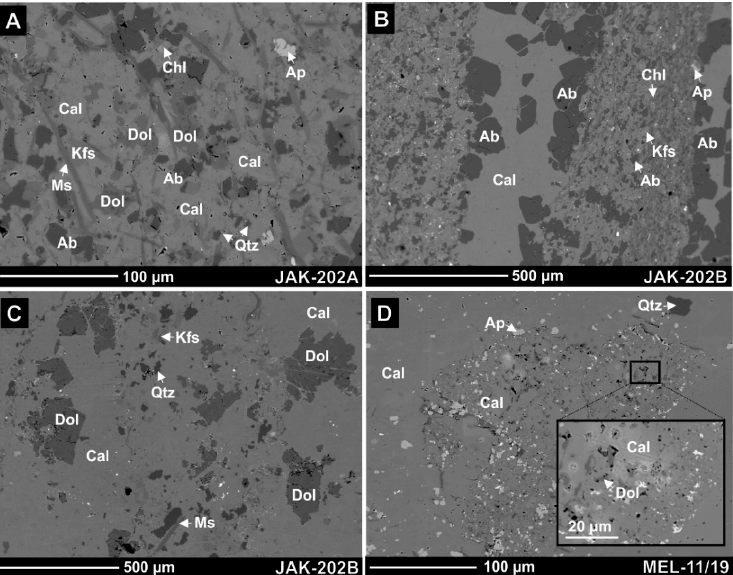
Figure 24. BSE images of carbonate-rich layers in Meliata Unit flysh ( A – C ) and a marble olistolith from the inferred B ô rka Unit ( D ); ( A – C ) Cal–Dol–Ab–Chl–Kfs–Qtz assemblage of the peak (D1) metamorphic stage from the carbonatic layer of calciclastic flysch at Jaklovce; ( D ) Cal–Dol–Cel-Ms assemblage of the peak (D1) metamorphic stage from a marble mylonite block in flysch at Meliata village. Younger coarse-grained Cal occurs in cross-cutting veinlets seen clearly in the upper left corner. Table 6. Representative analyses of calcite and dolomite from the Bôrka and Meliata units. Sample: